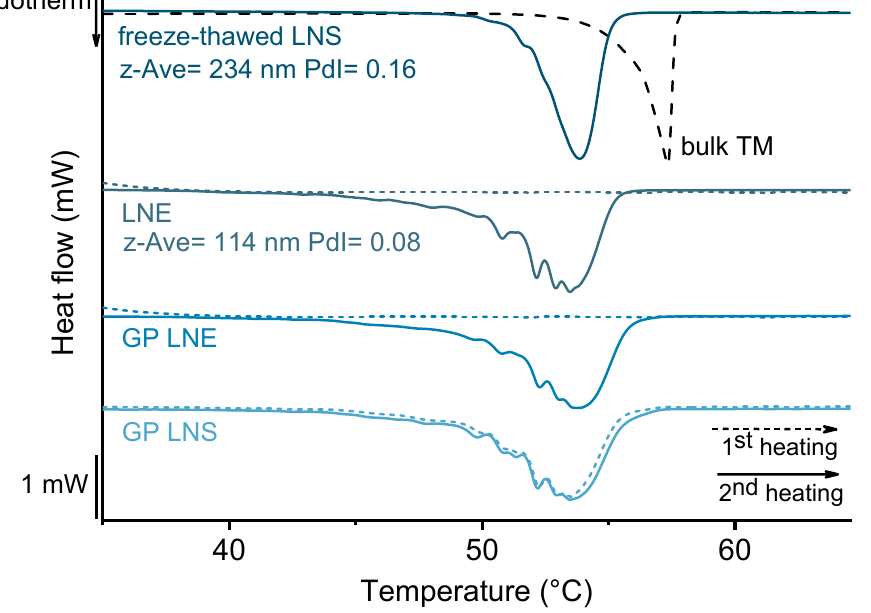
Figure 5. DSC heating curves of the original lipid nanoemulsion (LNE), lipid nanoemulsion and lipid nanosuspension incorporated into hydrogel particles (GP LNE and GP LNS, respectively) and a lipid nanosuspension measured after a freeze-thaw cycle (freeze-thawed LNS). Comparison of the signals of the first (dotted lines) and the second heating run (solid lines); the dashed line displays the melting signal of bulk trimyristin